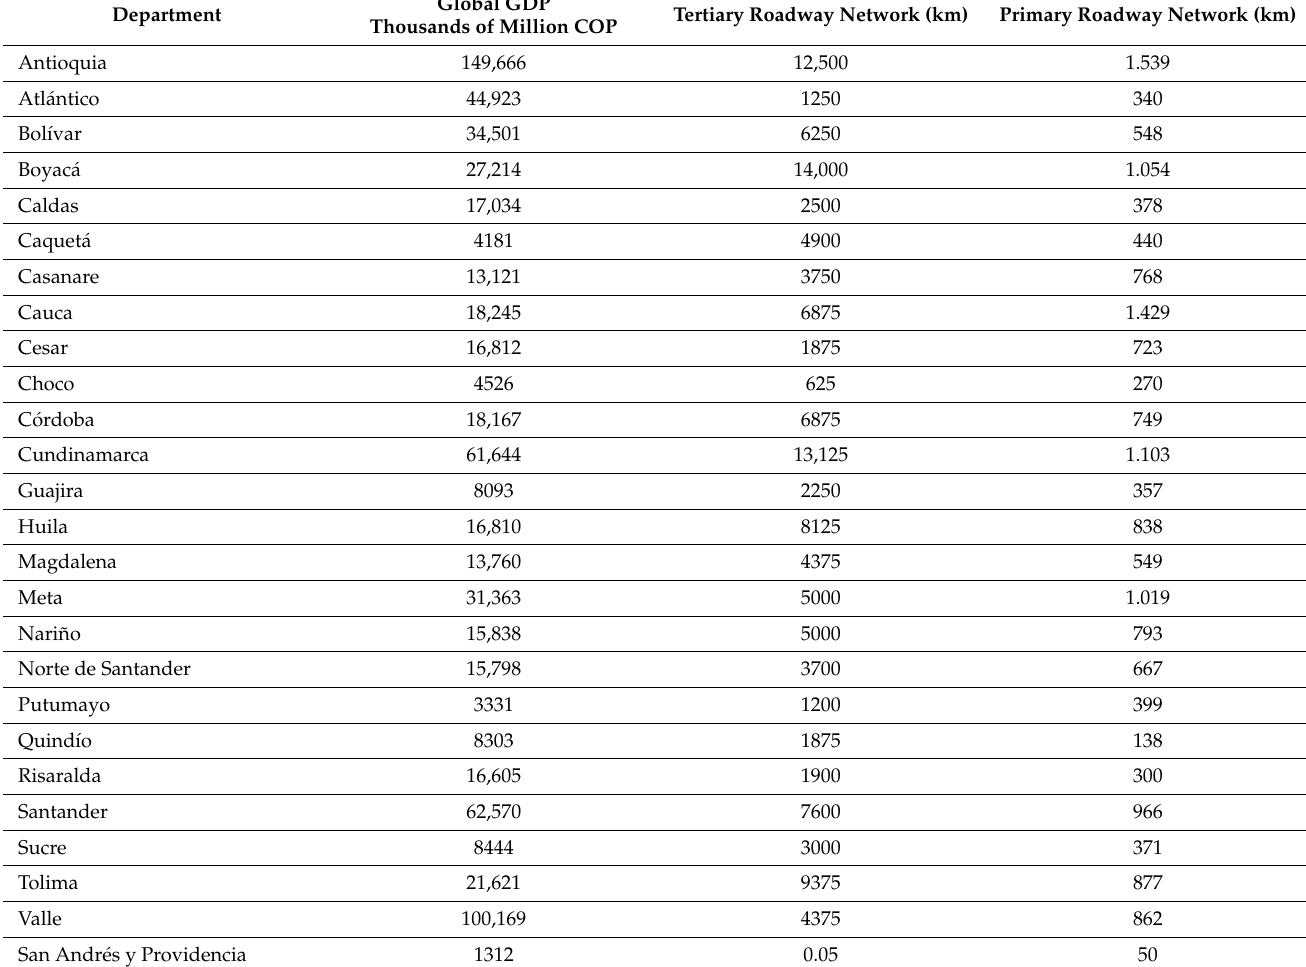
Table A9. Colombia department GDP 2020, and primary and tertiary roadway network